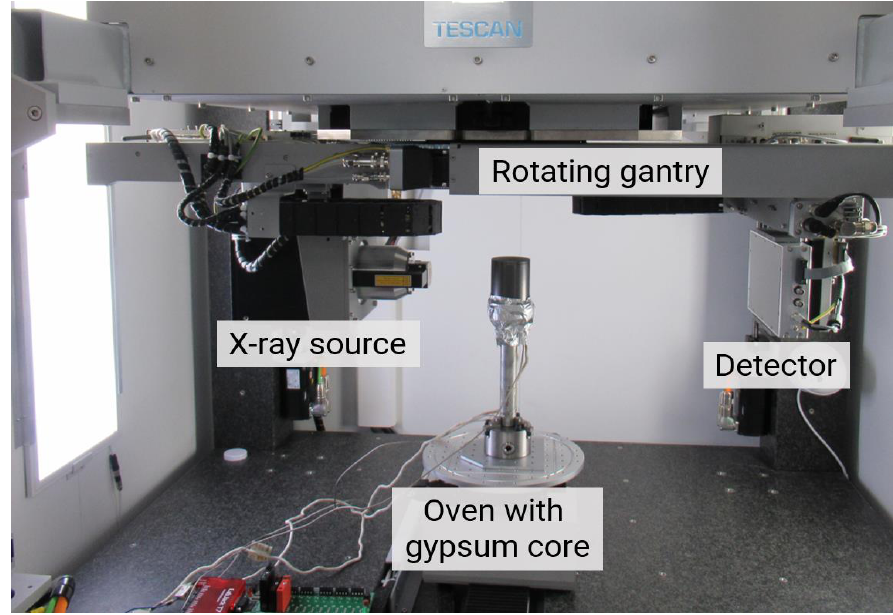
Figure 1. Oven with gypsum core samples mounted in the TESCAN DynaTOM, a horizontal gantry-based micro-CT system.